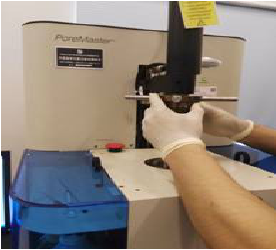
Figure 3. High-performance automatic mercury injection instrument.